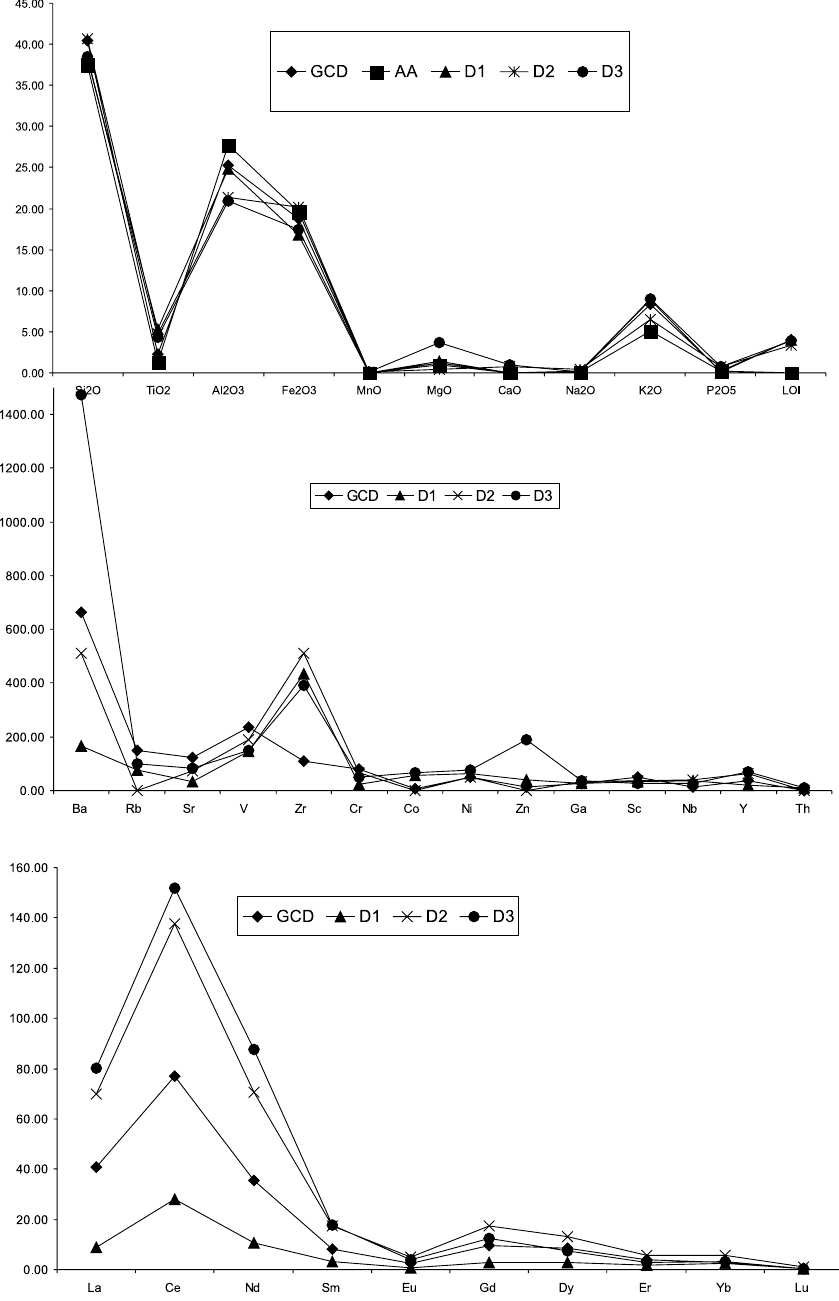
Fig. 4 – A plot of geochemical analyses showed in Table I. The sample GCD is the average for all samples from Chapada Diamantina – BA. Major elements (wt %), trace and REE elements (in ppm). Observe that the elements behavior of the Chapada Diamantina samples is similar to the elements behavior of the hematitic philite from Diamantina –